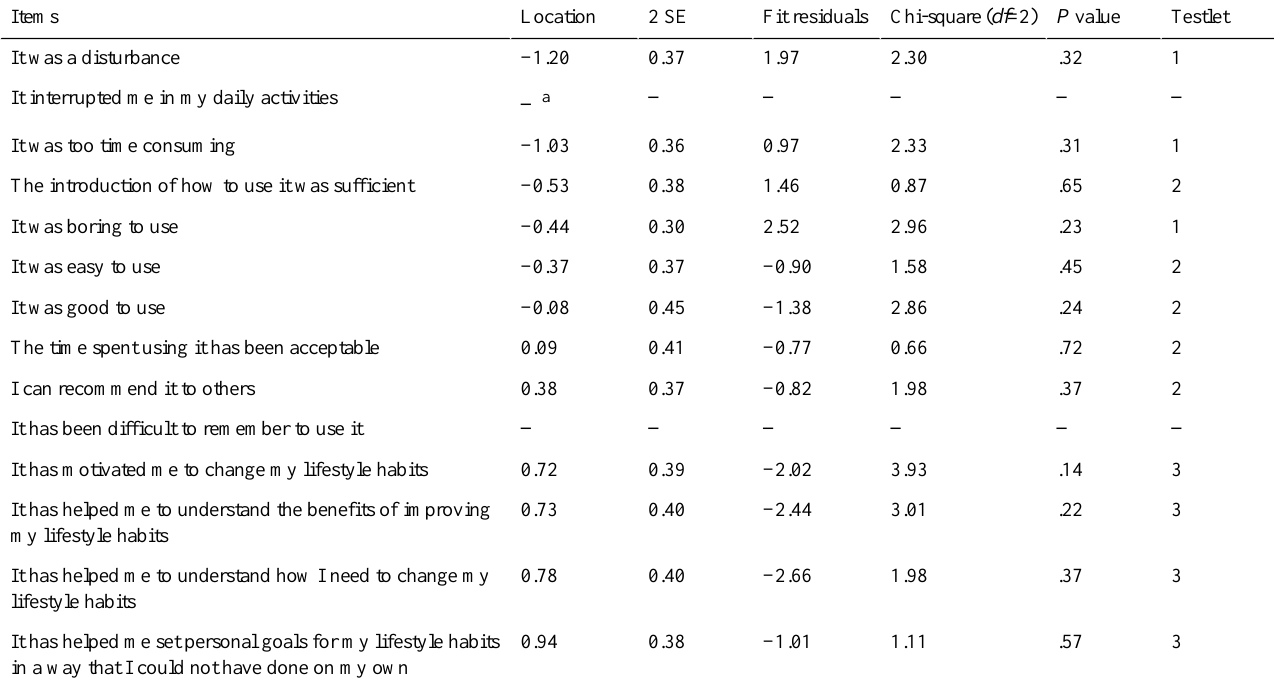
Table 2. Summary item statistics of the analyses for the version with 12